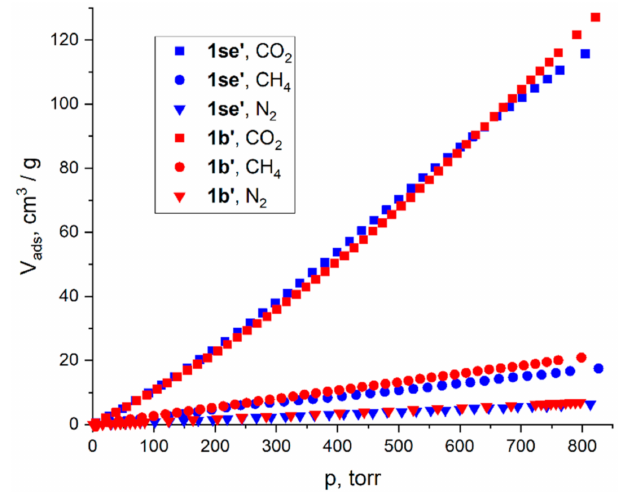
Figure 5. Gravimetric CO 2 , CH 4 , and N 2 sorption isotherms for 1se (cid:48) and 1b (cid:48) ( b ) at 273 K. Only adsorption branches are